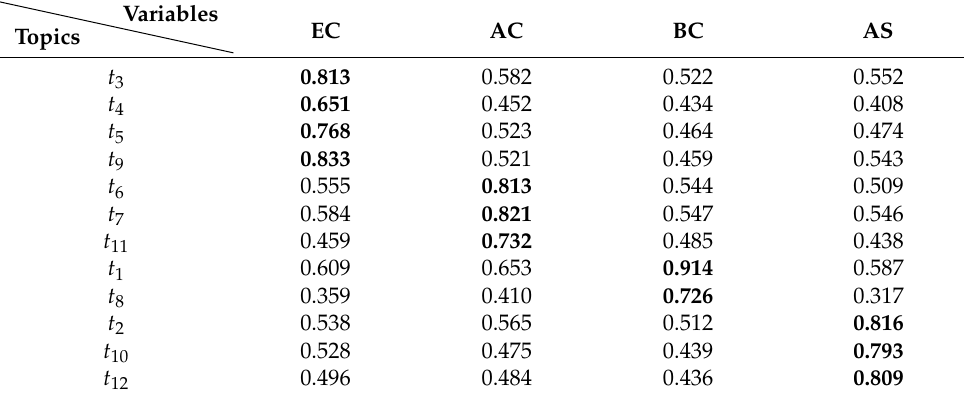
Table A3. Discriminant validity–Cross-loading